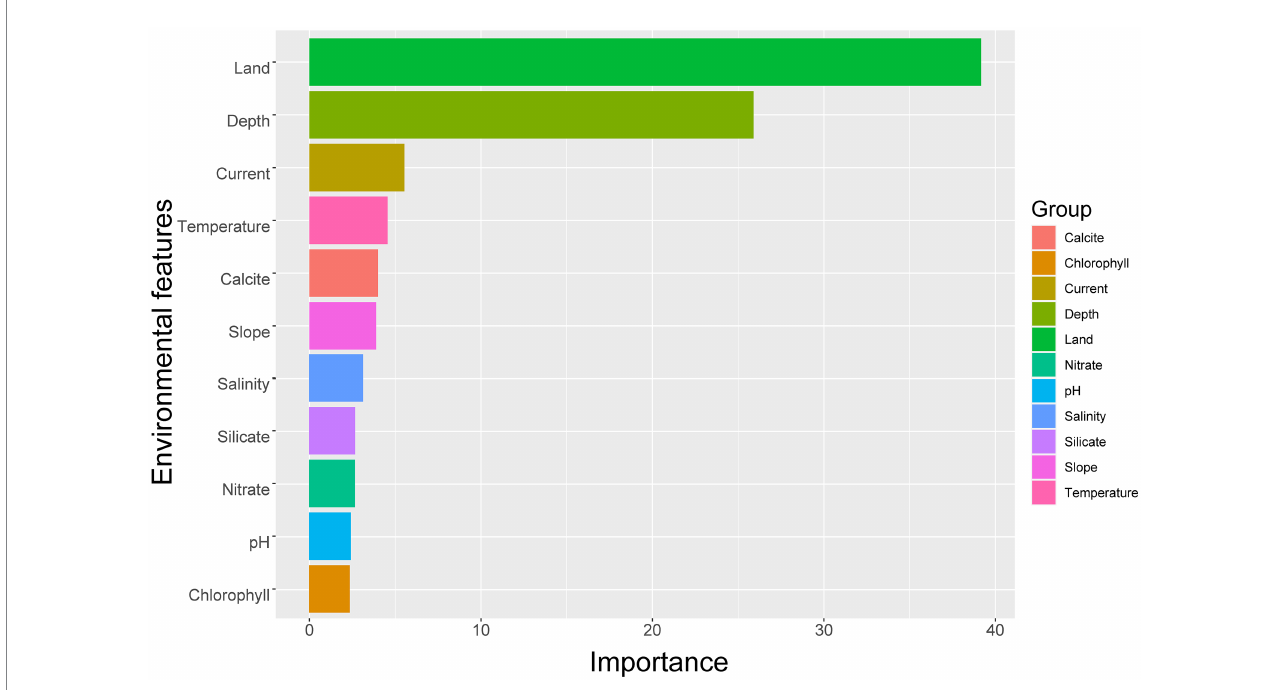
FIGURE 4 Importance analysis of 11 environmental